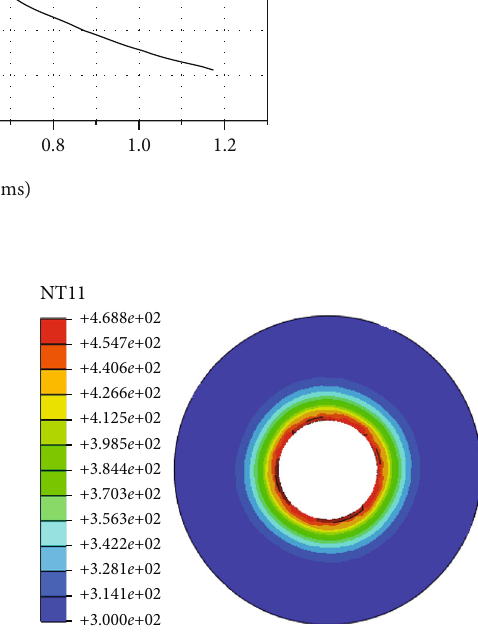
Figure 11: Temperature nephogram of the barrel during continuous fi